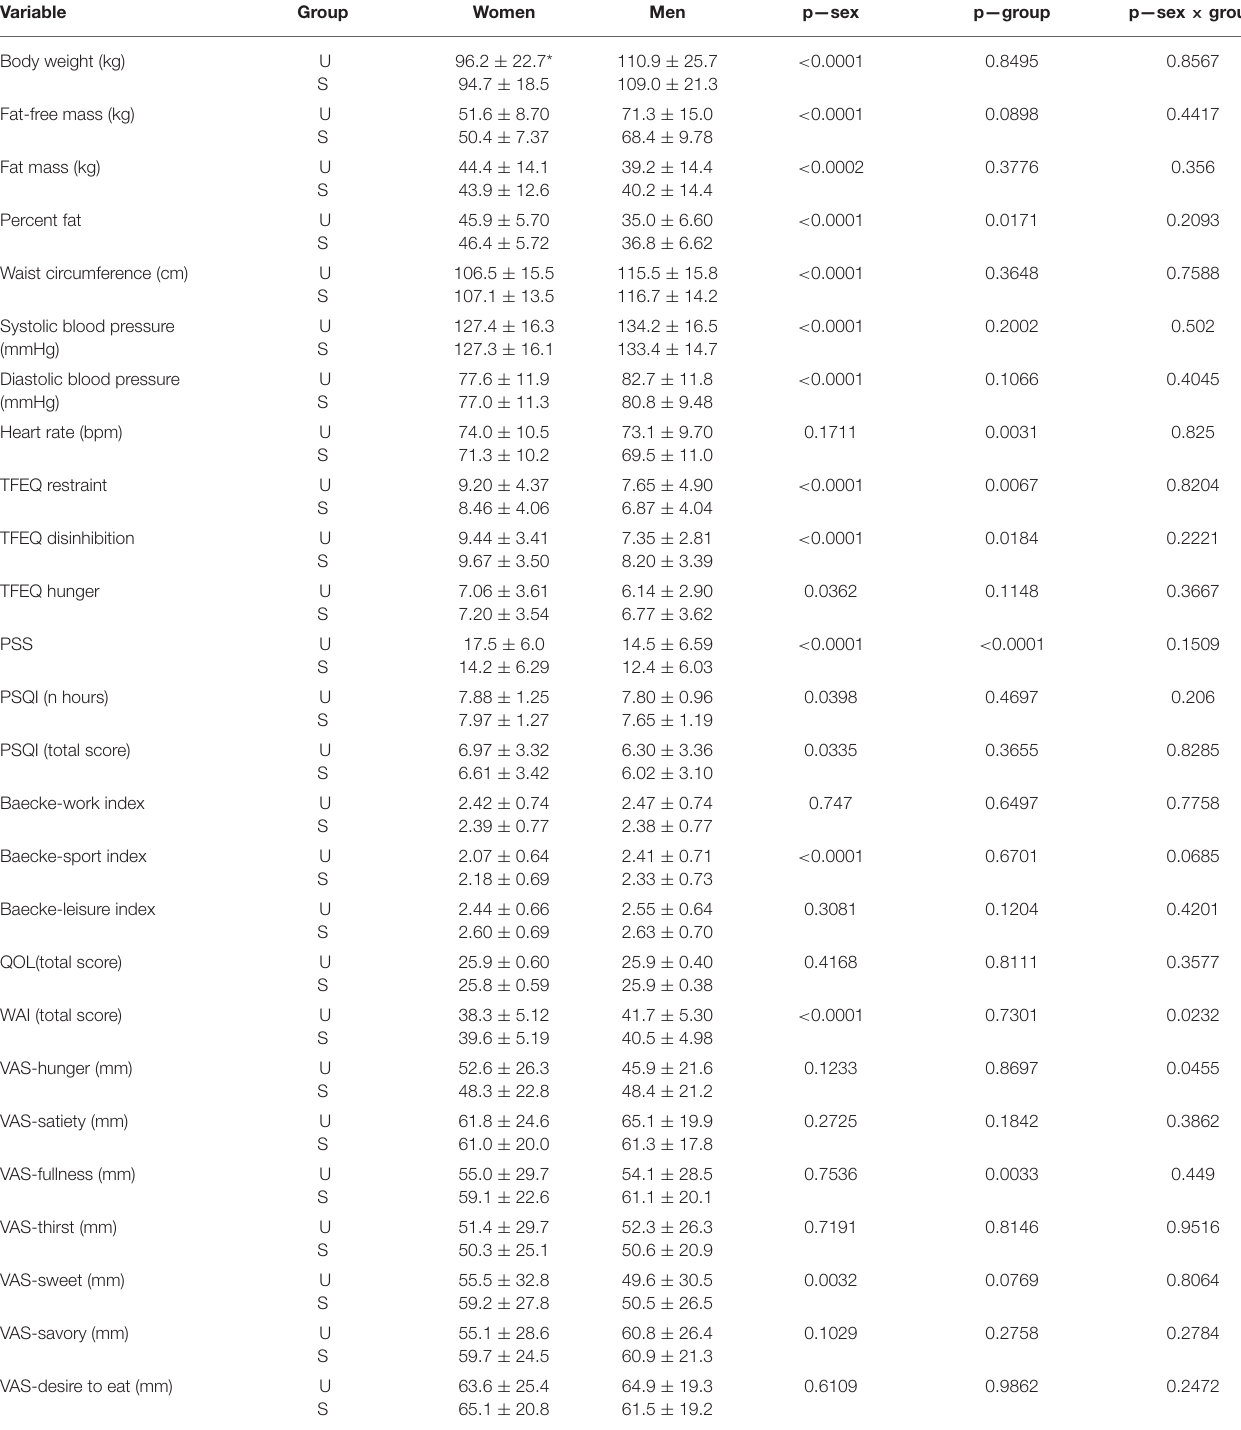
TABLE 2 | Baseline profile of the two groups of responders to LED. Variable Group p—sex p—group p—sex ×